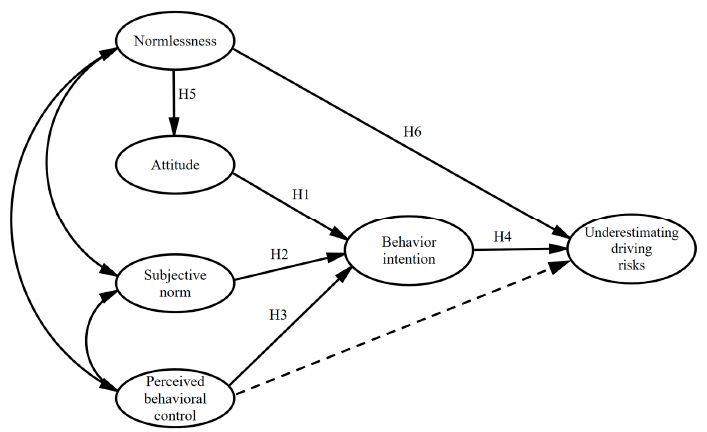
Figure 2. TPB model for driver underestimation of risk, dotted line indicates the impact of actual behavioral control.